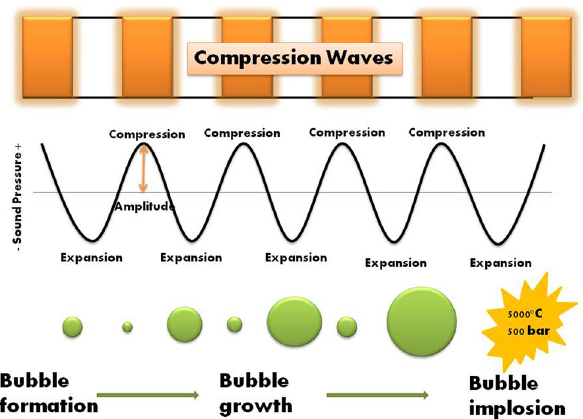
Figure 1: Cavitation